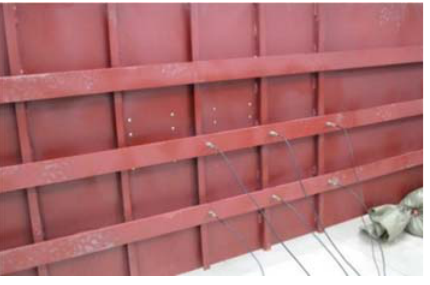
Figure 14: Photo of the steel grillage and measuring points.